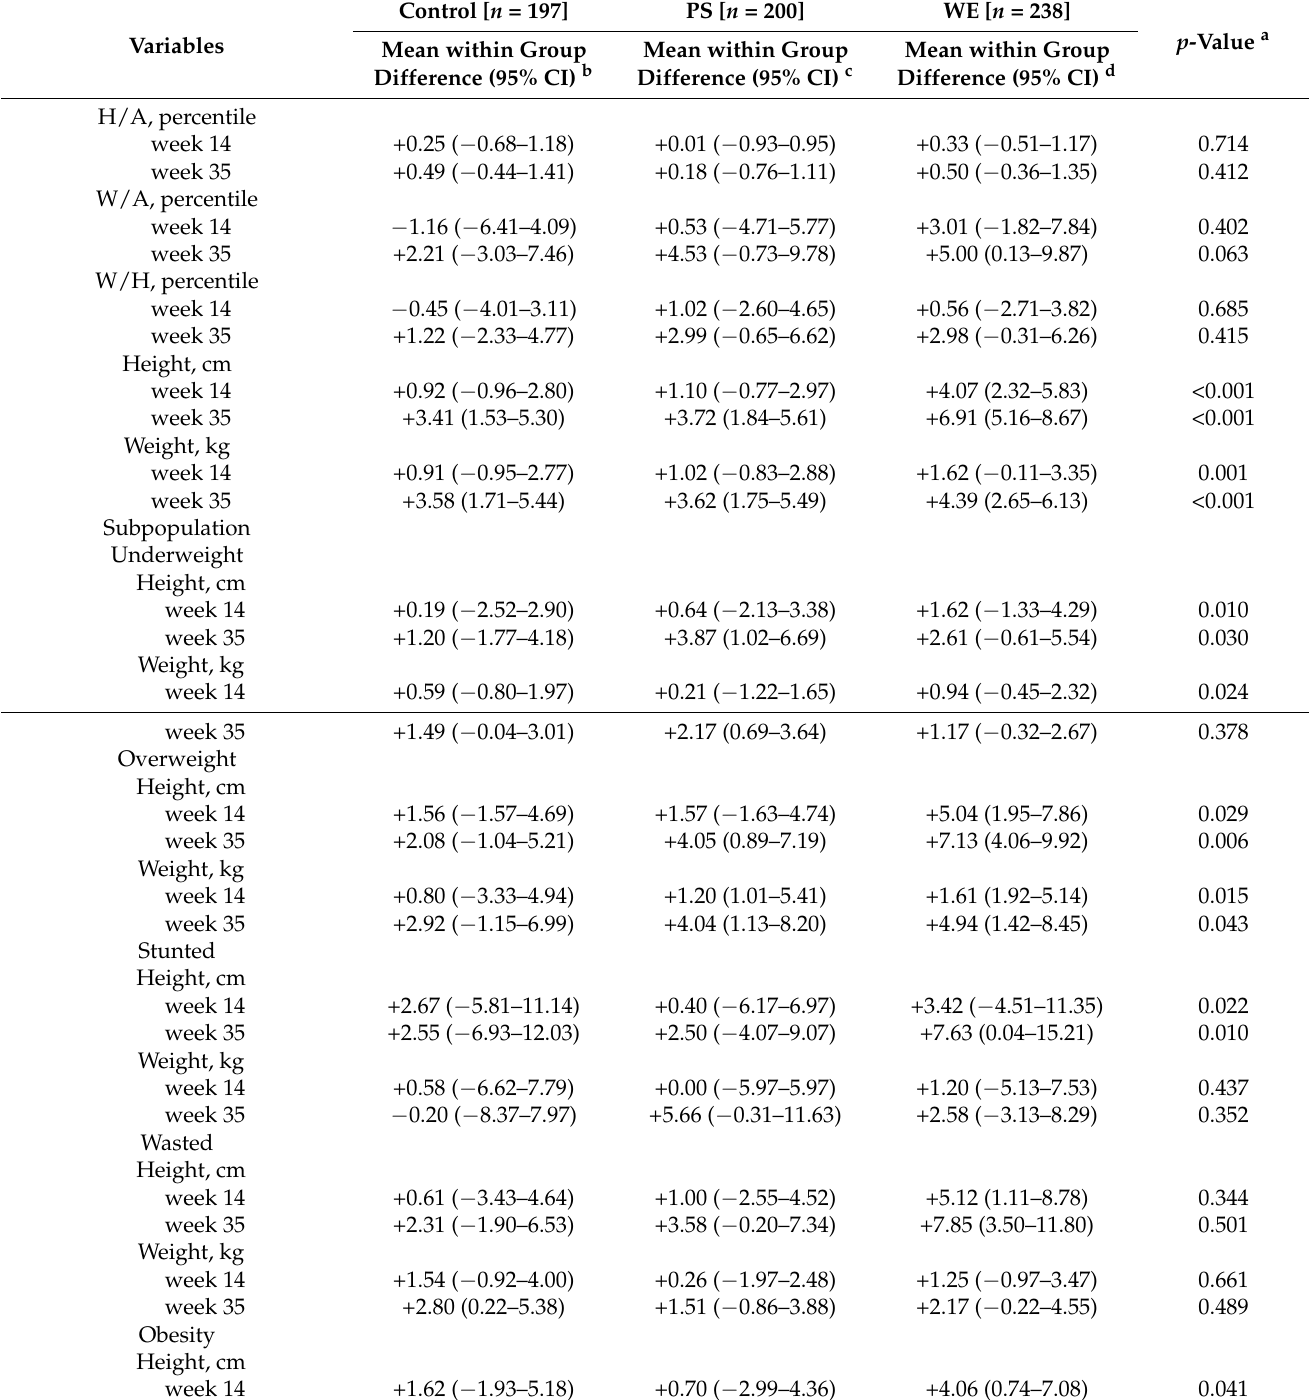
Table 2. The 14 and 35 weeks change estimates for anthropometric and biochemical indices of